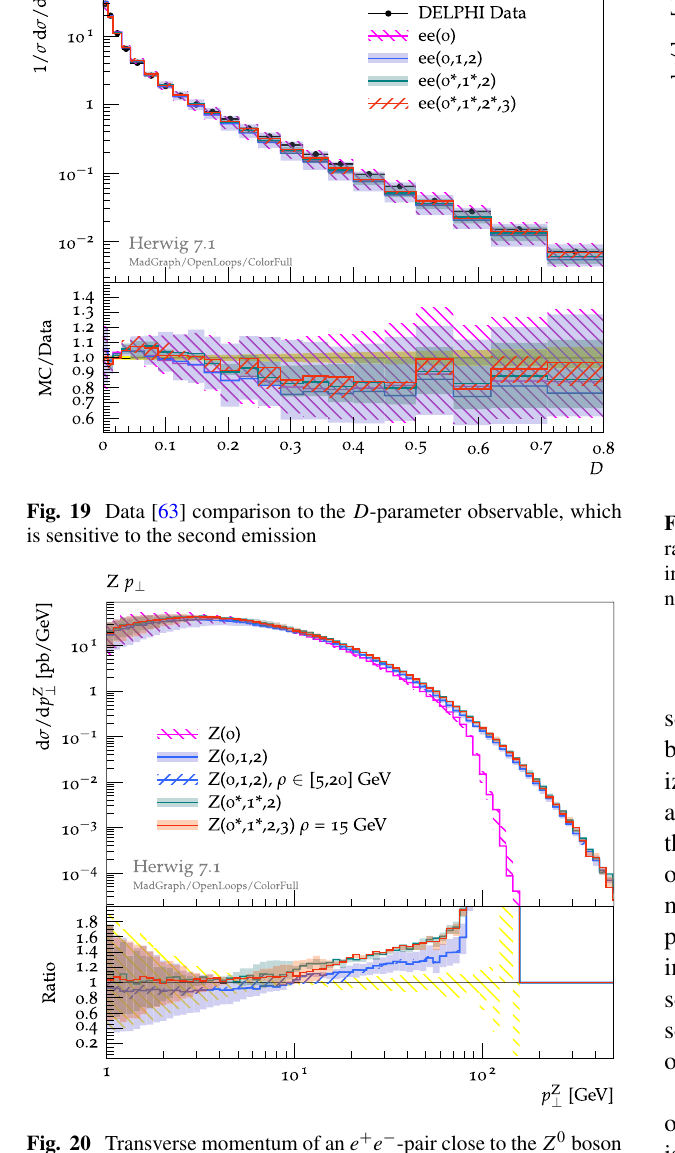
Fig. 20 Transverse momentum of an e + e − -pair close to the Z 0 boson mass. While the LO distribution dies out at the Z mass due to phase space restrictions, the merged distributions fill the full phase space. The uncertainty bands are produced by synchronized variation of the renormalization and factorization scale in the shower and ME calcula- tion. The NLO corrections to the first emission reduce the uncertainty estimate in the region above the merging scale